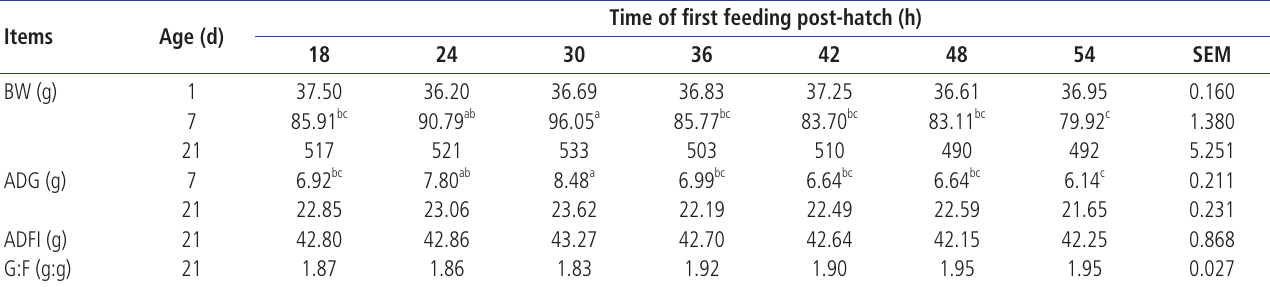
Table 4. Effects of first feeding time on intestinal digestive enzyme activities of broilers on d 4 Enzyme Items (U/g protein)